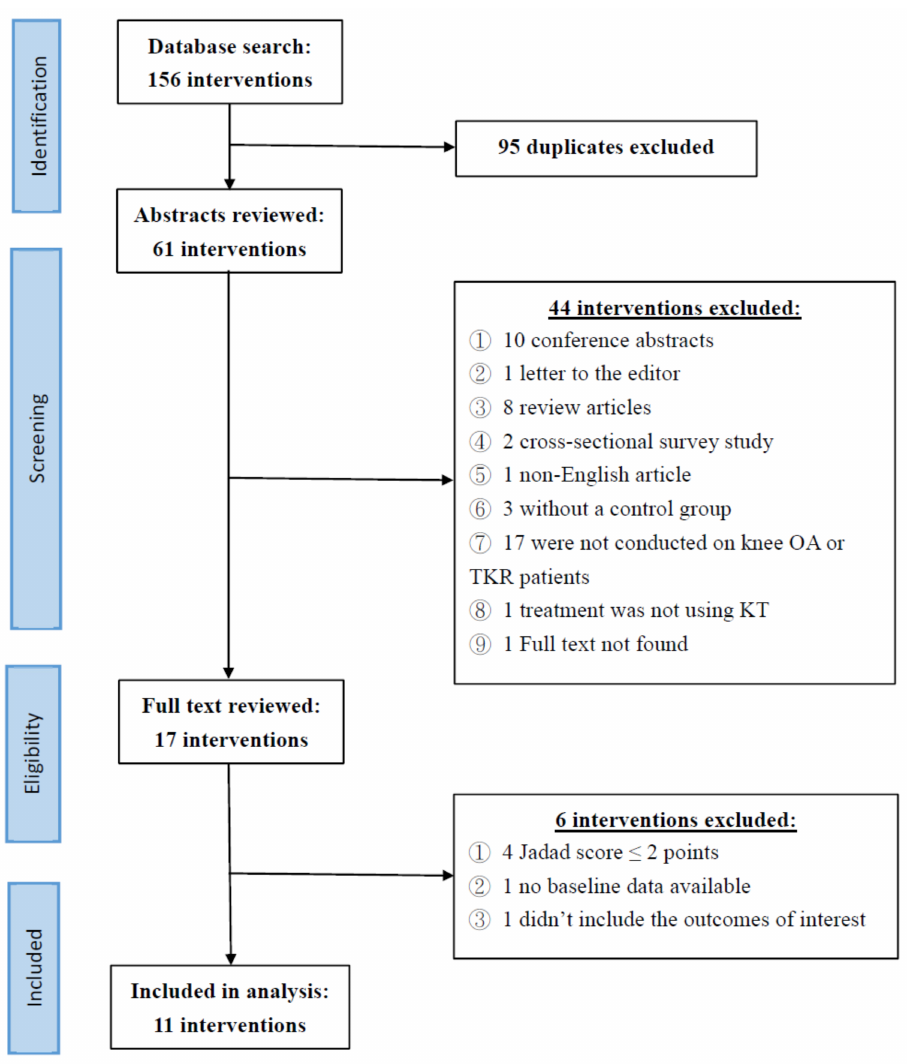
Figure 1. Flowchart of literature search (OA = osteoarthritis; TKR = total knee replacement; KT = kinesio